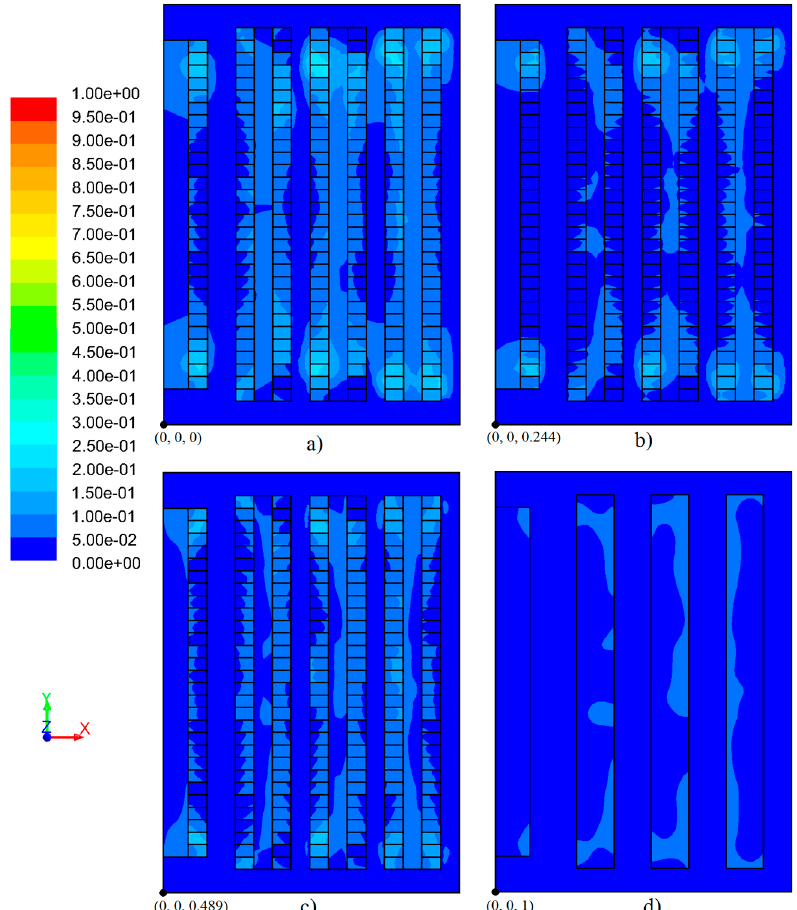
Figure 11. The results of the field of temperature in the x–z plane through the planes: ( a ) y adm = 0.100; ( b ) y adm = 0.485; and ( c ) y adm = 0.900.